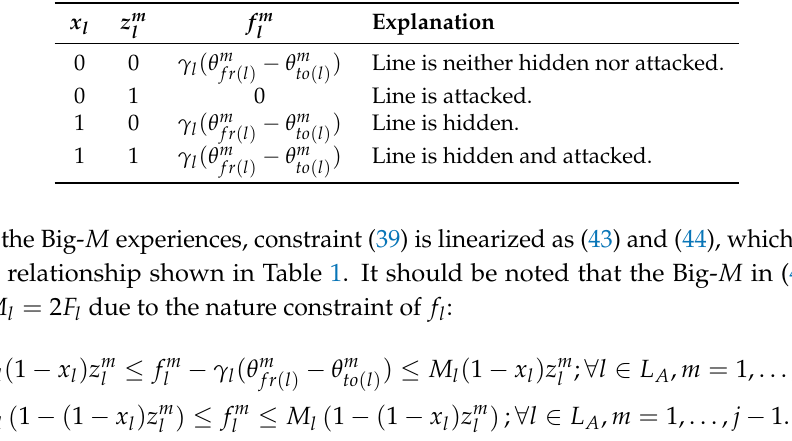
Table 1. Logic relationship between f m